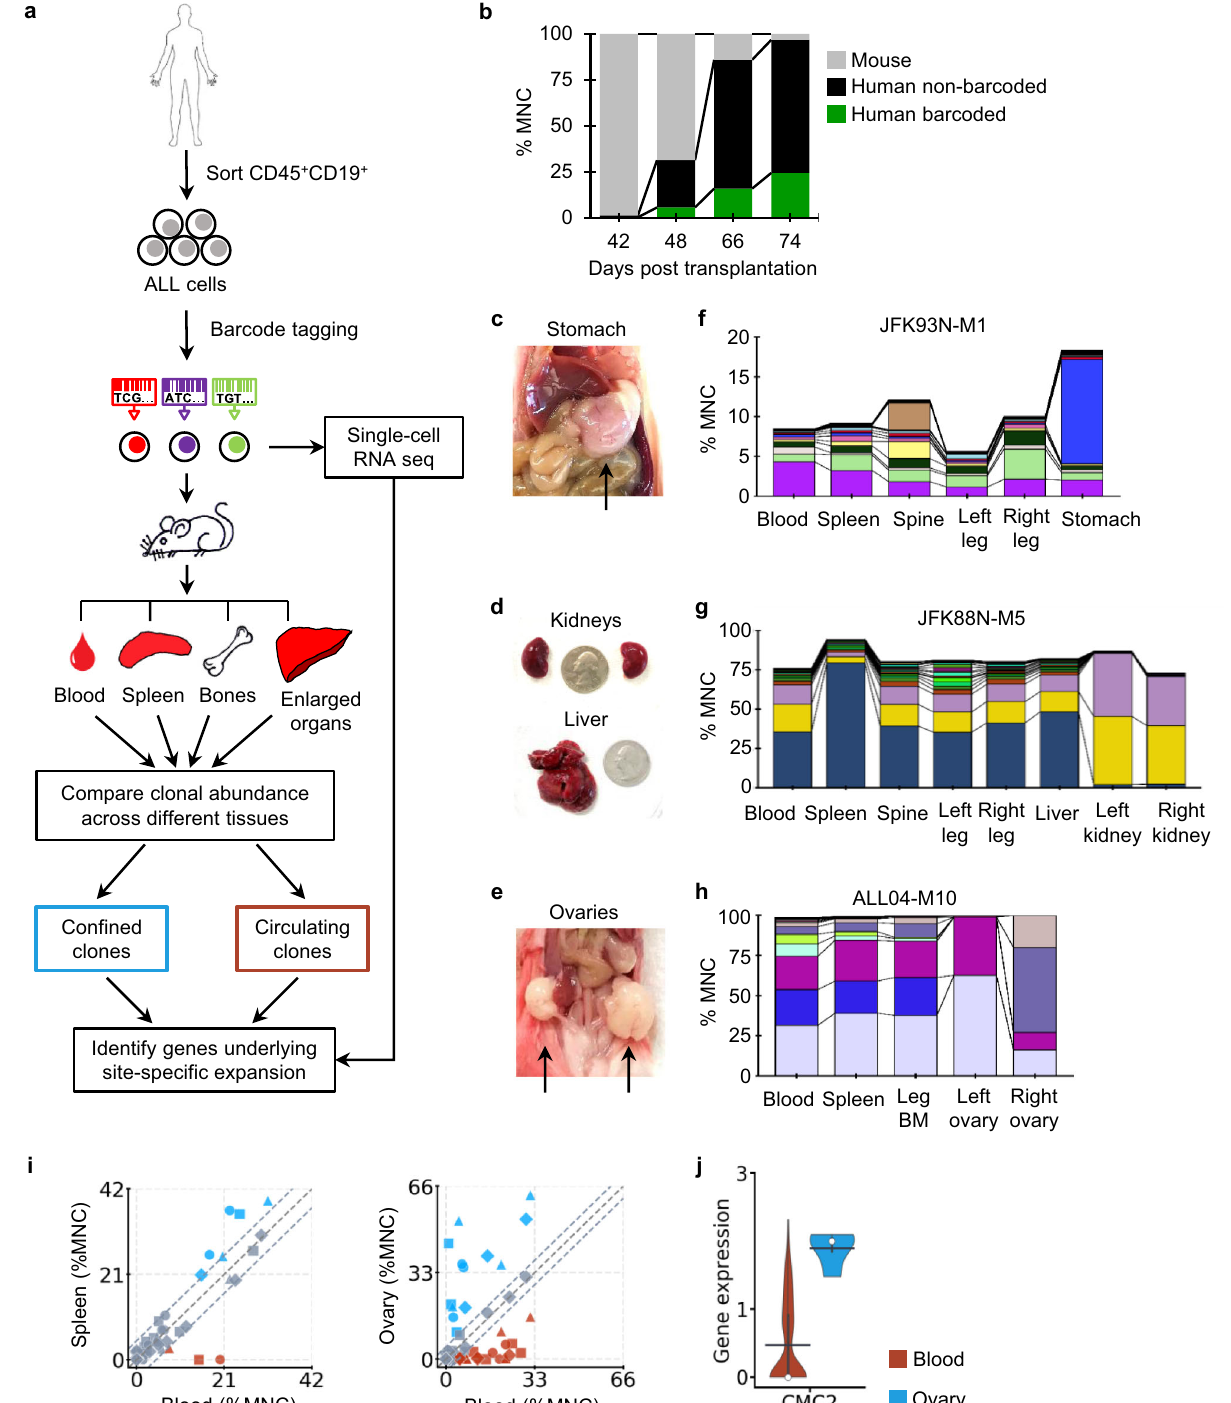
Fig. 1 Distinct leukemia clones expanded in extramedullary organs. a Clonal abundance was assessed in different tissues and organs and mapped to single-cell RNA sequencing data. b The fractions of mouse cells, non-barcoded human leukemia cells (GFP − ), and barcoded human leukemia cells (GFP + ) in the mononuclear cells (MNC) of the peripheral blood from a xenografted mouse over time. c – e Representative images showing extramedullary sites of leukemia expansion. Quarters are shown in ( d ) as size references. Additional mice are shown in Supplementary Fig. 4. f – h Clonal distribution across different tissues and organs in representative mice. Each color represents one distinct genetic barcode corresponding to a leukemia clone. Additional mice are shown in Supplementary Figs. 5 and 6c, f. i Comparison of clonal abundance between the peripheral blood and the spleen or the ovary. Markers of the same shape represent data from one mouse. 99% con fi dence intervals of correlation were determined by the blood and spleen comparison and highlighted by dashed gray lines. j The CMC2 gene was signi fi cantly upregulated in clones more abundant in the ovary than clones more abundant in the blood. The black bar indicates the mean, and the white dot represents the median. Source data are provided as a Source Data fi